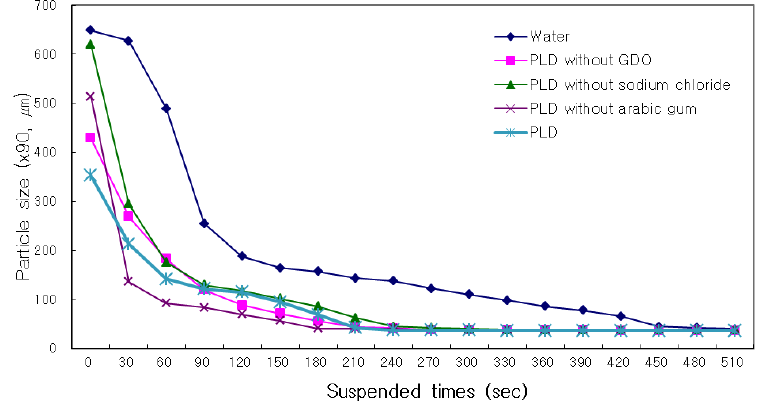
y Mean separation within columns by Duncan’s multiple range test at 5% level. Results are from five replicates. Replicates above consist of fruits from 30 flower clusters signed on the pollination time of each tree at 30 days after pollination.